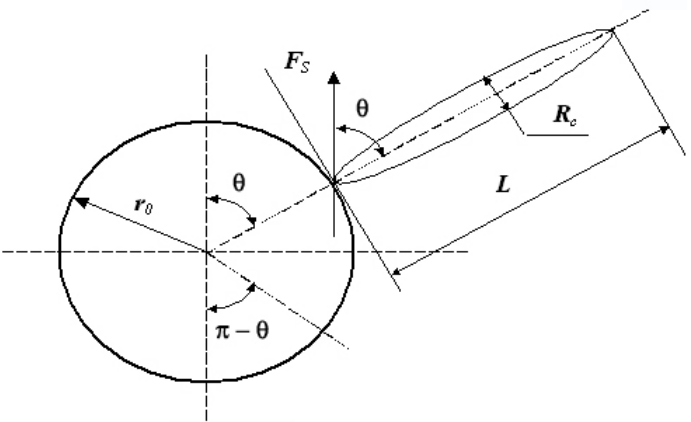
Figure 2. The interaction diagram between the protonated polymer molecule and the anion complex of the extracted metal and the flows inside the oscillating droplet, which allows estimating the conditions of this bond destruction.